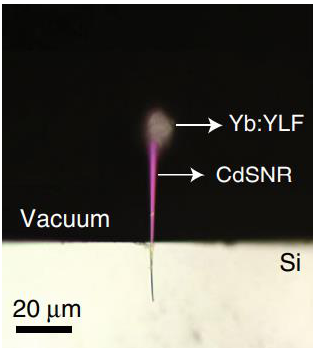
Figure 6. The CdSNR cantilever supported by a silicon substrate. A Yb 3+ :YLF crystal is placed at the free end of the cantilever [30].